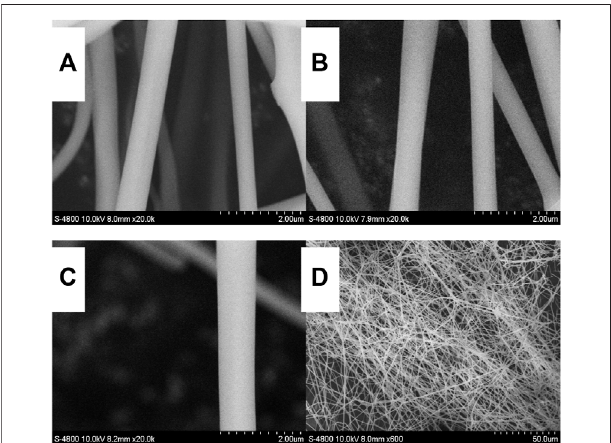
FIGURE 5 | SEM photos of Eu (N-DPNQ) (TTD)3/PVP: (A) Eu 1 , (B) Eu 2 , (C) Eu 3 and (D) a large scale view of Eu 2